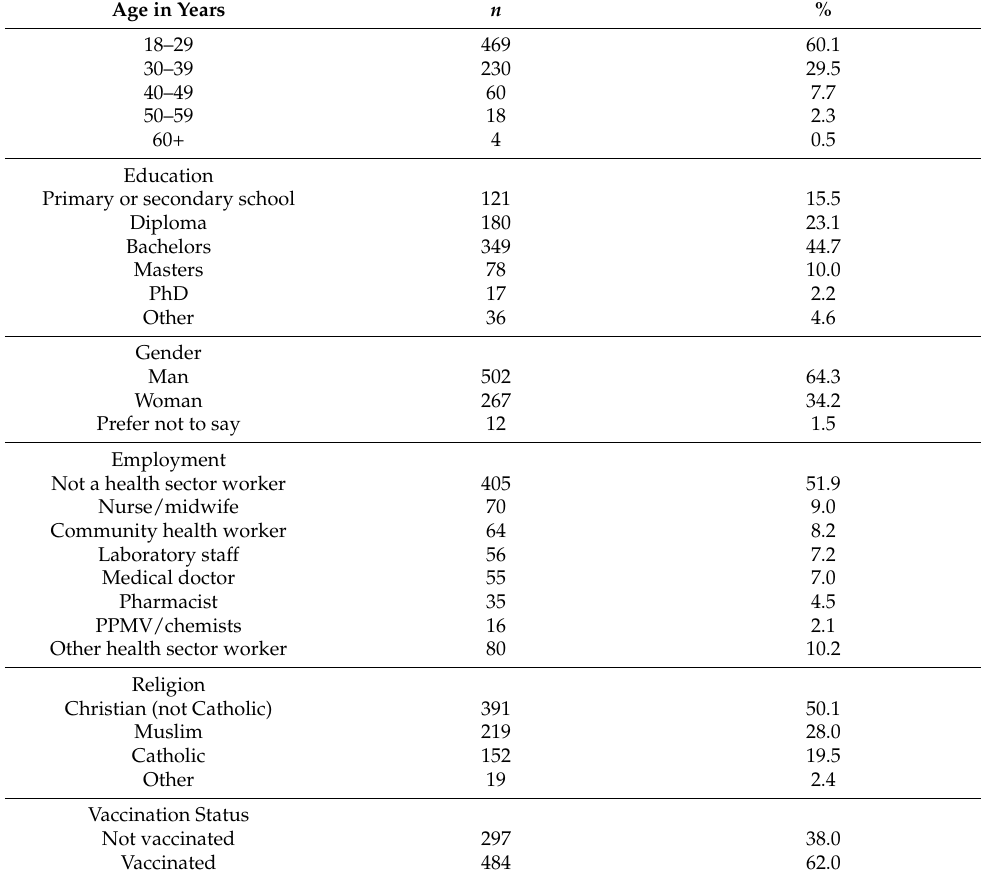
Table 1. Sociodemographic characteristics of the